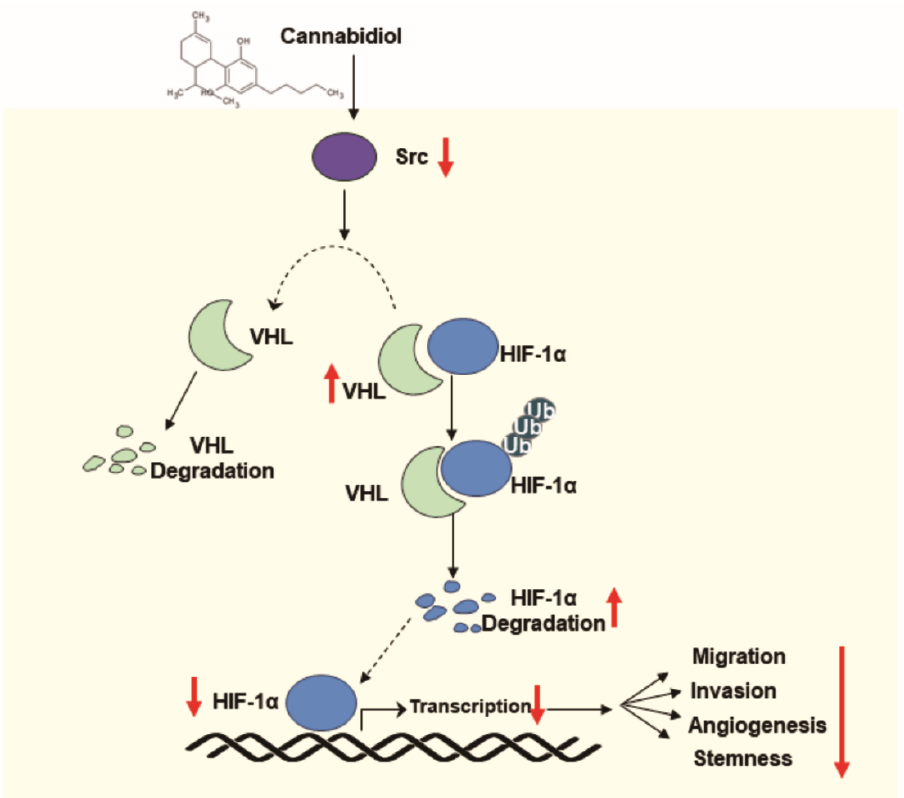
Figure 6. The scheme of cannabidiol (CBD) suppression of angiogenesis and stemness of breast cancer by downregulation of HIF-1 α .